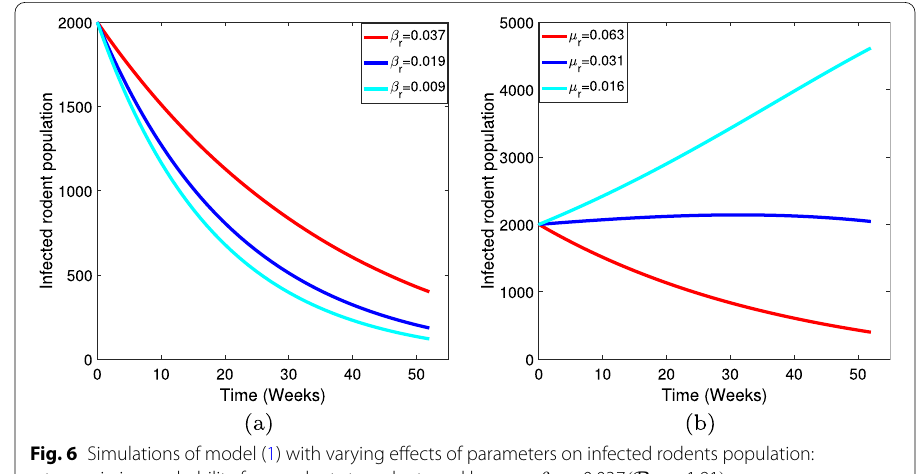
Fig. 6 Simulations of model (1) with varying effects of parameters on infected rodents population: a transmission probability from rodents to rodents and humans β r = 0.037 ( R 0 = 1.91 ) , β h = 0.019 ( R 0 = 1.61 ) , and β r = 0.009 ( R 0 = 1.46 ) ; b natural death rate of rodents µ r = 0.063 ( R 0 = 1.91 ) , µ r = 0.031 ( R 0 = 2.49 ) , µ r = 0.016 ( R 0 = 3.68 ) . Other parameter values used are as given in Table